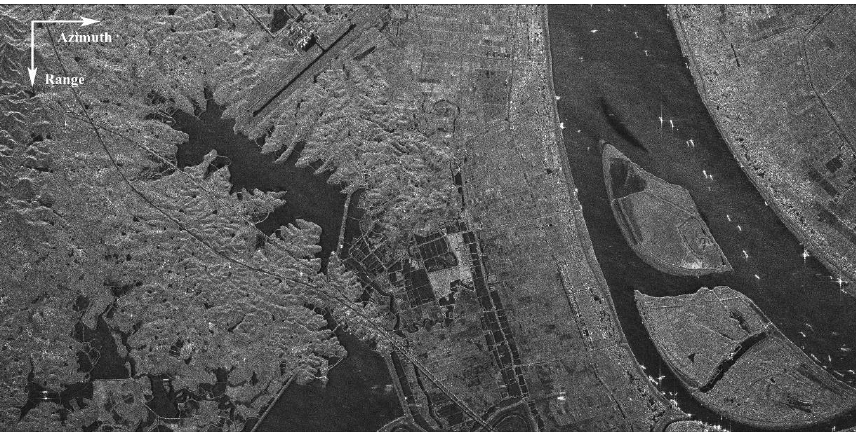
Figure 1. Imaging scene for synthetic aperture radar-ground moving target indication (SAR-GMTI) Figure experiment.